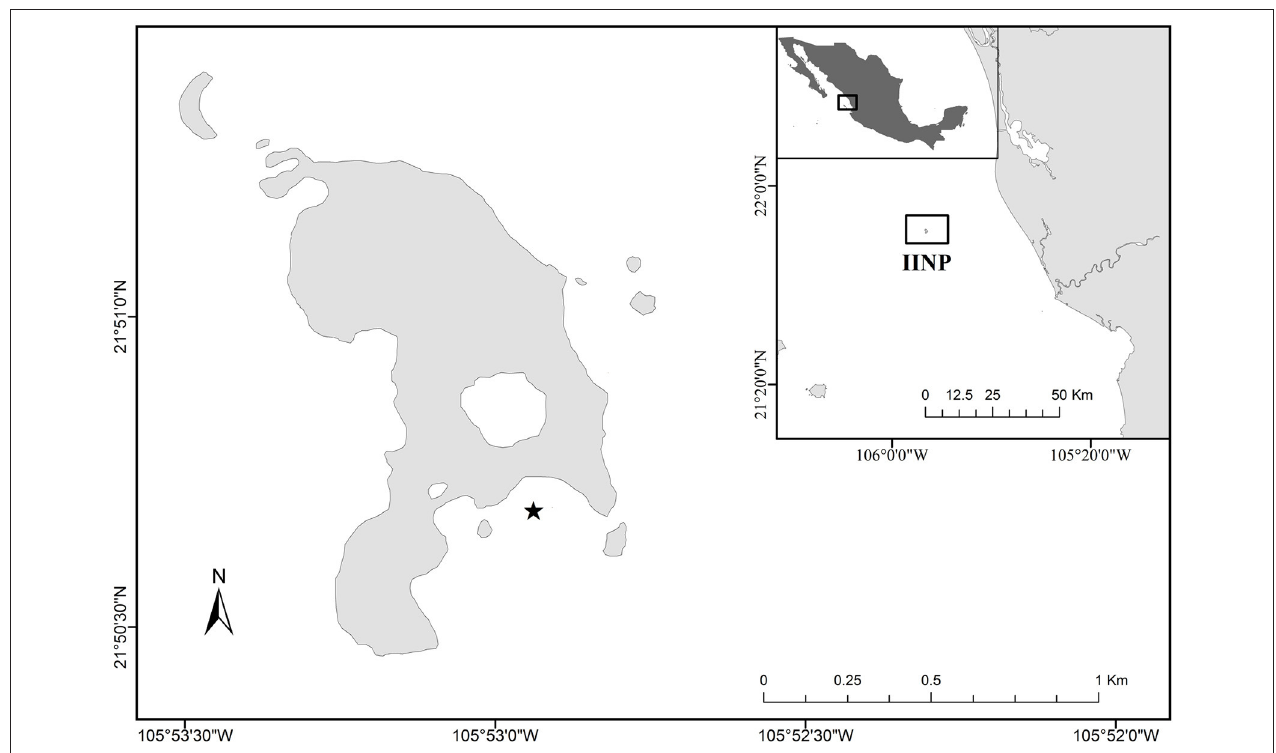
FIGURE 1 | Study area, Isla Isabel National Park (IINP). Black star denote the site of